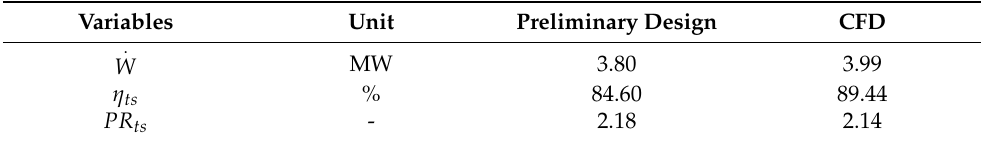
Table 6. Results of the preliminary design and CFD after blade optimization.